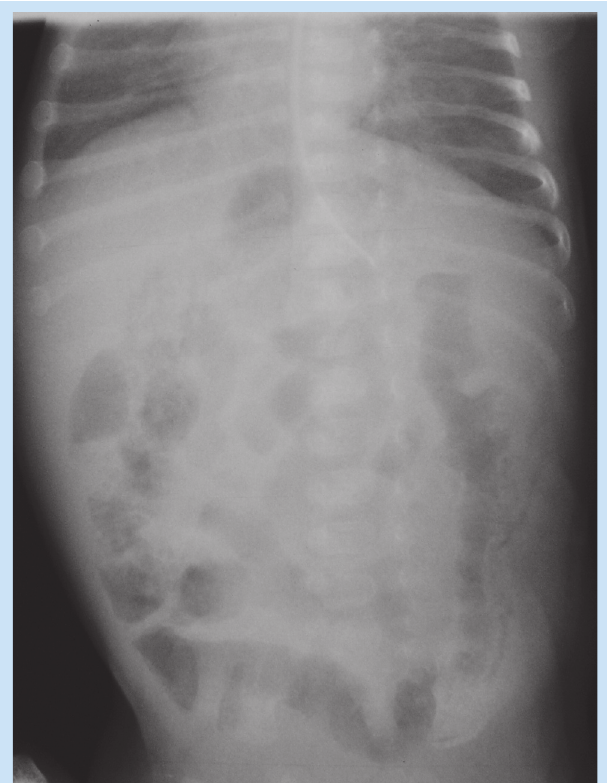
Fig. 24. The features below the diaphragm are also important and are often associated with prematurity. In this patient there is mural bowel gas in keeping with necrotising